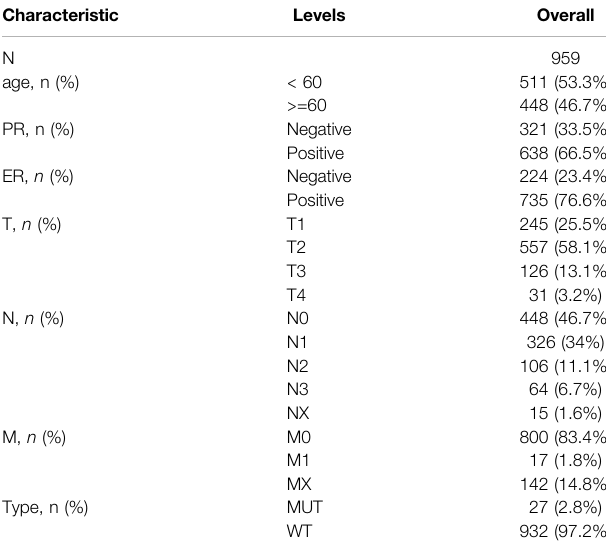
TABLE 1 | TCGA-BRCA patient baseline information (Note: The total number of patients with BRCA in this table is 959 and the total number of patients in the dataset is 1,085; this difference is due to a lack of clinical information such as PR, ER or TNM stage for some patients. Owing to the missing information, only 959 patients with complete information on the following characteristics were